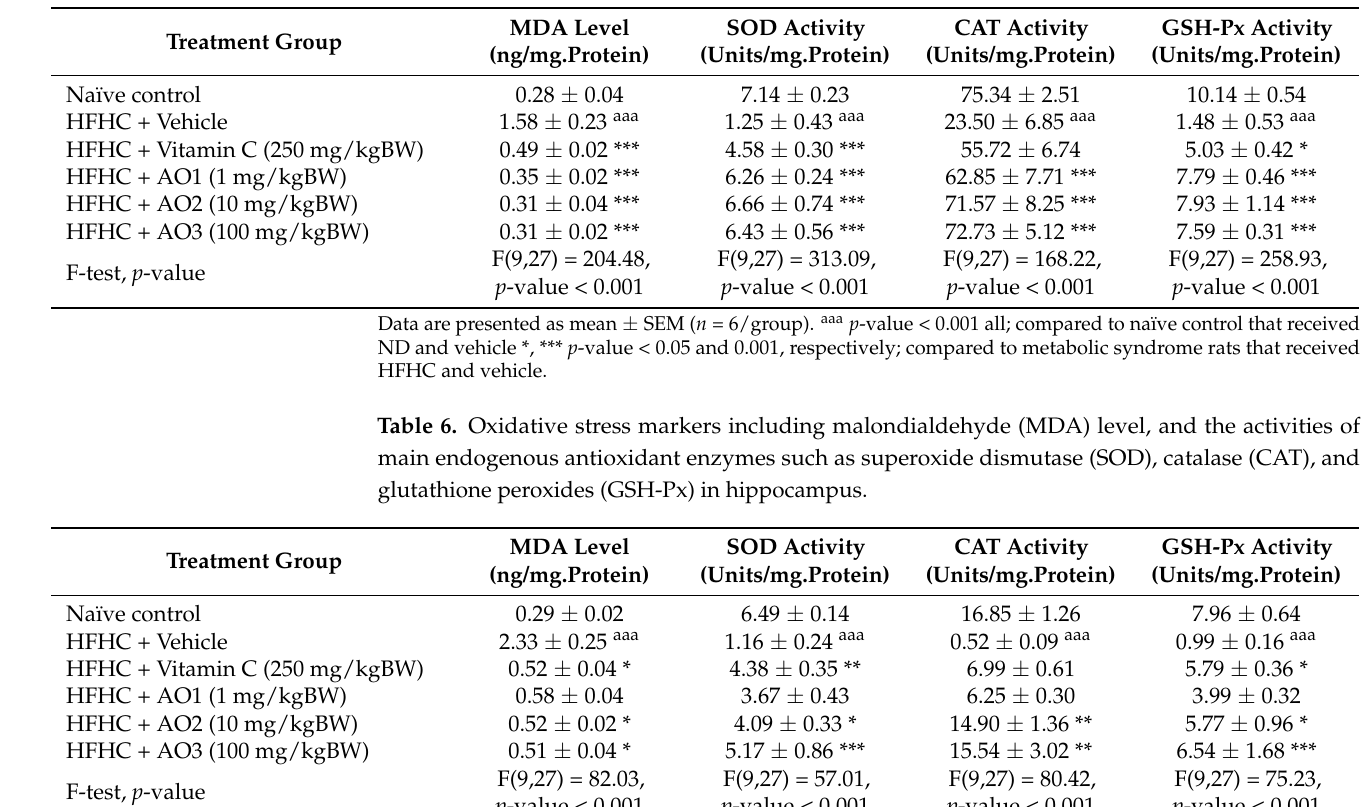
Table 5. Oxidative stress markers including malondialdehyde (MDA) level, and the activities of main endogenous antioxidant enzymes such as superoxide dismutase (SOD), catalase (CAT), and glutathione peroxides (GSH-Px) in cerebral cortex.